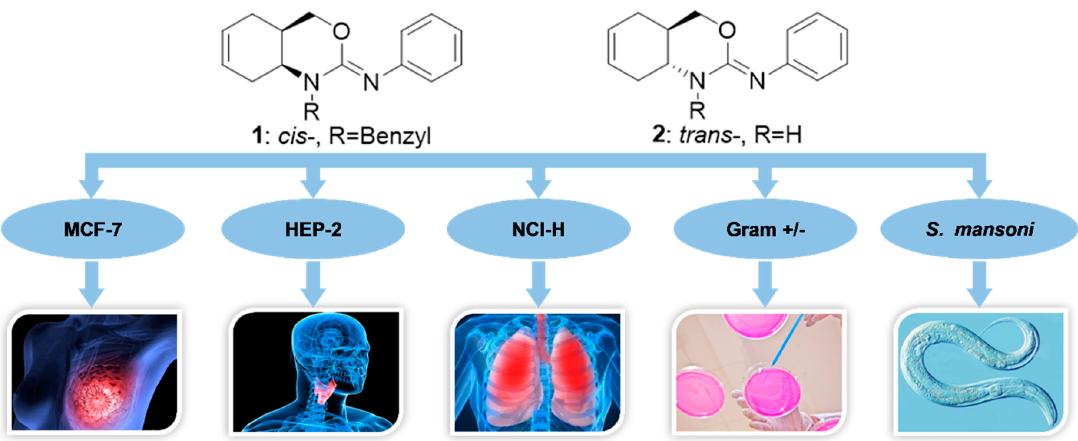
Figure 1. cis-1-benzyl- N -phenyl-1,4,4a,5,8,8a-hexahydro-2 H -benzo[d][1,3]oxazin-2-imine ( 1 ) and trans- N -phenyl-1,4,4a,5,8,8a-hexahydro-2 H -benzo[d][1,3]oxazin-2-imine ( 2 ) prepared for this study and their different biological activities previously described. MCF-7: Michigan Cancer Foundation, type 7 human breast carcinoma cells; HEP-2: Human epithelial, type 2 human larynx carcinoma cells; NCI-H: National Cancer Institute, human lung carcinoma cells; S. mansoni : Schistosoma mansoni .